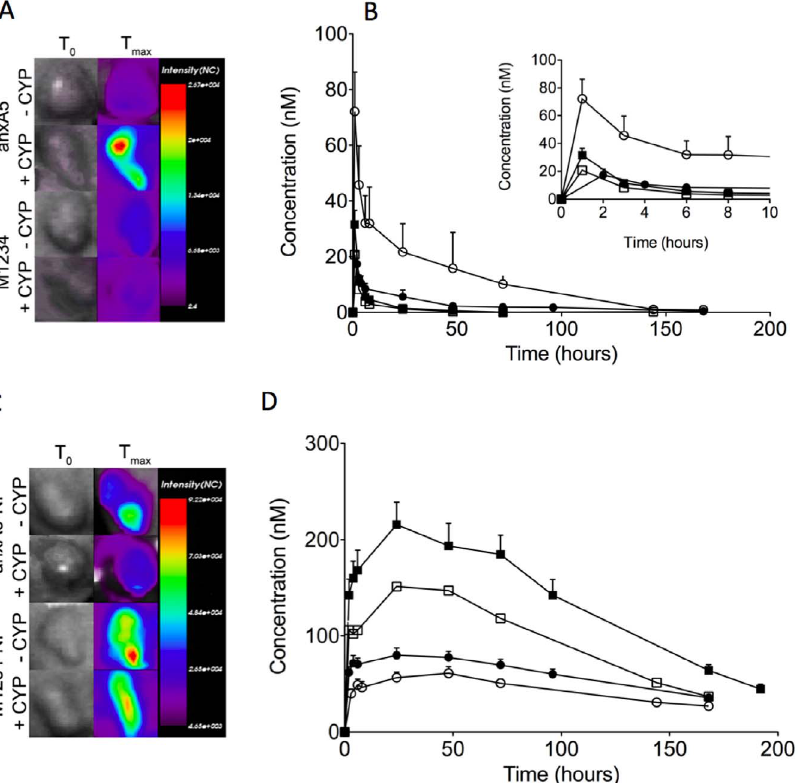
Figure 6. Non-invasive optical imaging of kinetics of tumor-uptake of fluorescently labeled annexin-variants in tumor bearing NMRI nude mice untreated (–CYP) or treated with cyclophosphamide ( + CYP). Panels A and C show representative pictures of tumors of mice injected with anxA5 and M1234 (A), and anxA5-NP and M1234-NP (C). Panel B illustrates the time courses of tumor levels of anxA5 (closed circles, –CYP; open circles, + CYP) and M1234 (closed squares, –CYP; open squares, + CYP). The inset shows the time-courses during the first 10 hours. Panel D represents the time-courses of tumor levels of anxA5-NP (closed circles, –CYP; open circles, + CYP) and M1234 (closed squares, –CYP; open squares, + CYP).